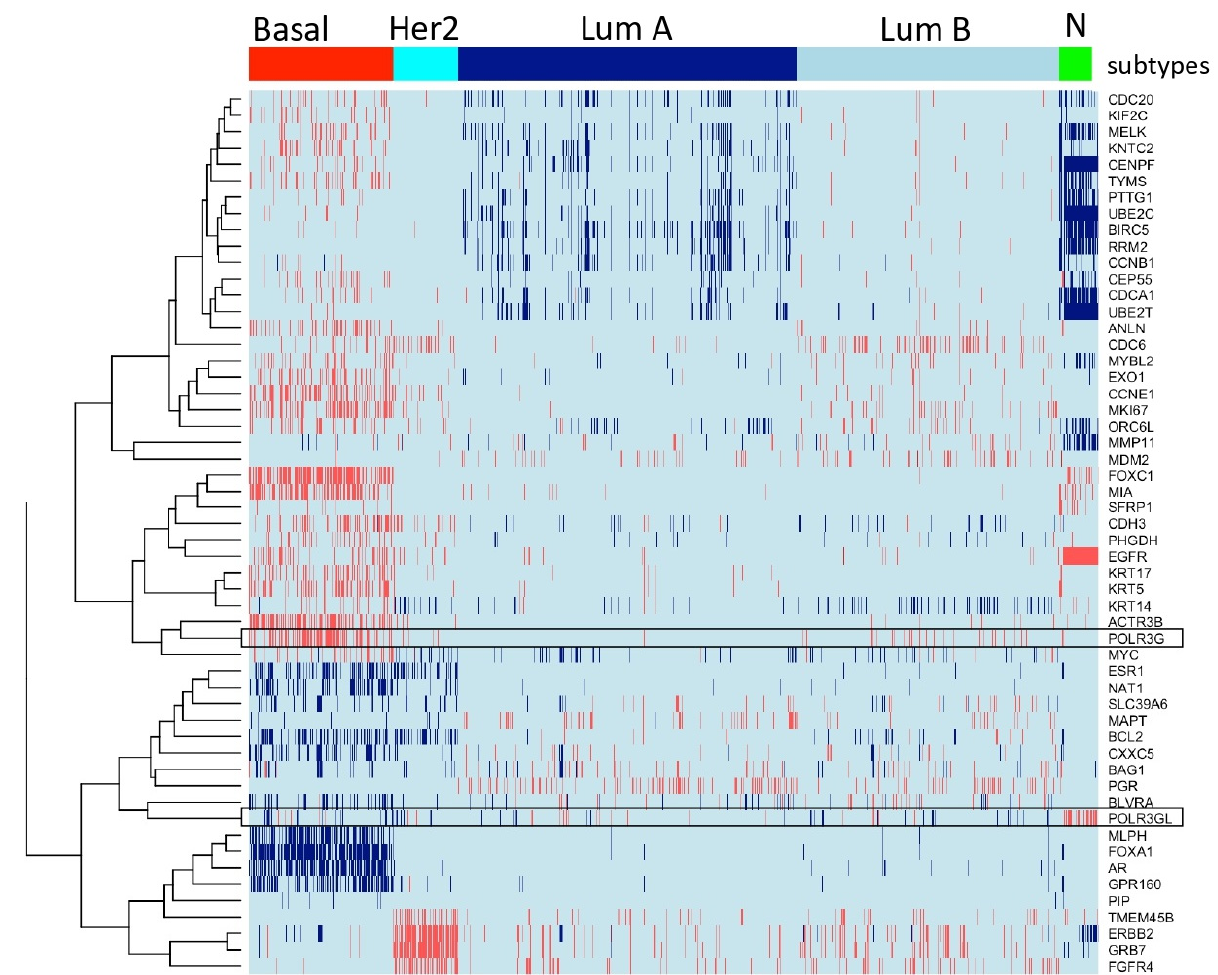
Figure 1. POLR3G is specifically overexpressed in samples derived from basal breast cancer patients. Heatmap representing 2627 clinical samples of breast cancer and controls (columns). PAM50 genes according to Lehmann’s refined classification [22] are appropriately in rows and are used for clustering samples according to their gene expression profiles. The expression profiles of POLR3G and POLR3GL across samples are shown in boxed rows. High transcript levels are marked in red, and low levels are marked in blue. Transcriptomes were collected from public repositories (see Materials and Methods). PAM50 classification identified the following distribution of subtypes: 445 basal (including triple ‐ negative), 202 Her2, 1046 luminal A (LumA), 812 luminal B (LumB) tumors and 122 normal breast tissue samples (N). Colors correspond to levels of mRNA. POLR3G mRNA expression is higher in the basal group than in other subtypes. POL3GL mRNA expression is higher in normal breast tissues than in breast cancer samples ( p value < 10 − 100 ; see Table S1).